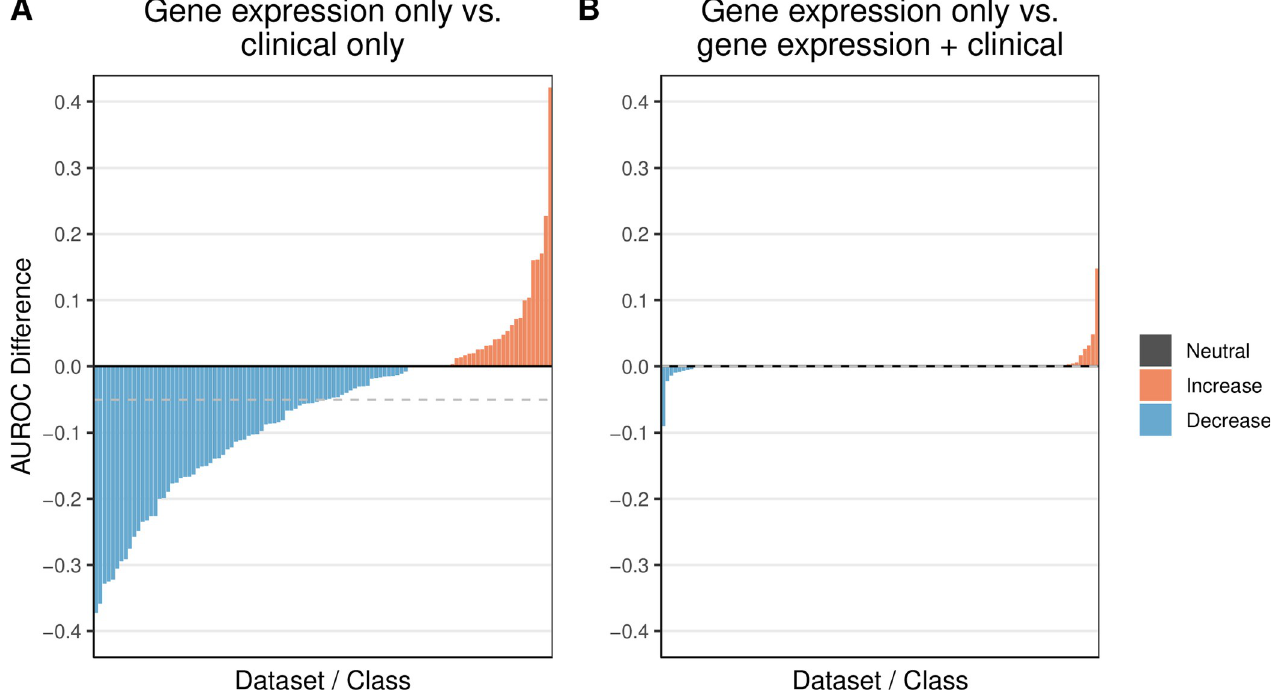
Fig 4. Relative predictive performance when training on gene-expression predictors alone vs. using clinical predictors alone or gene-expression predictors in combination with clinical predictors. In both A and B , we used as a baseline the predictive performance that we attained using gene-expression predictors alone (Analysis 1). We quantified predictive performance using the area under the receiver operating characteristic curve (AUROC). In A , we show the relative increase or decrease in performance when using clinical predictors alone (Analysis 2). In most cases, AUROC values decreased; however, in a few cases, AUROC values increased (by as much as 0.42). In B , we show the relative change in performance when using gene-expression predictors in combination with clinical predictors (Analysis 3). For 82/109 (75%) of dataset/class combinations, including clinical predictors had no effect on performance. However, for the remaining combinations, the AUROC improved by as much as 0.15 and decreased by as much as 0.09.